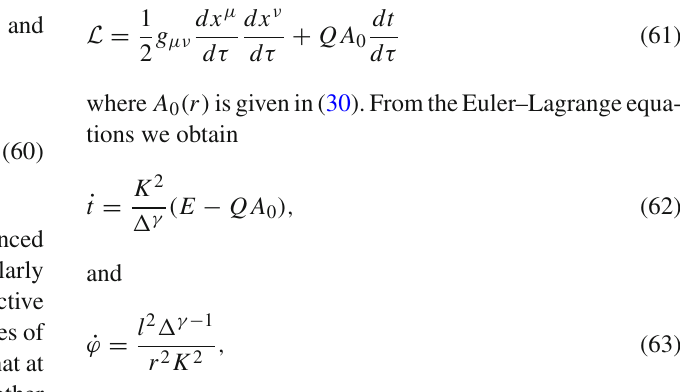
Fig. 9 Variation in the bending angle δ versus x is plotted for the com- pactobject4U1538-52.Thestarisconsideredforthecasesofuncharged stationary (ω (cid:8)= 0 ) , static charged ( q (cid:8)= 0 ) and static uncharged